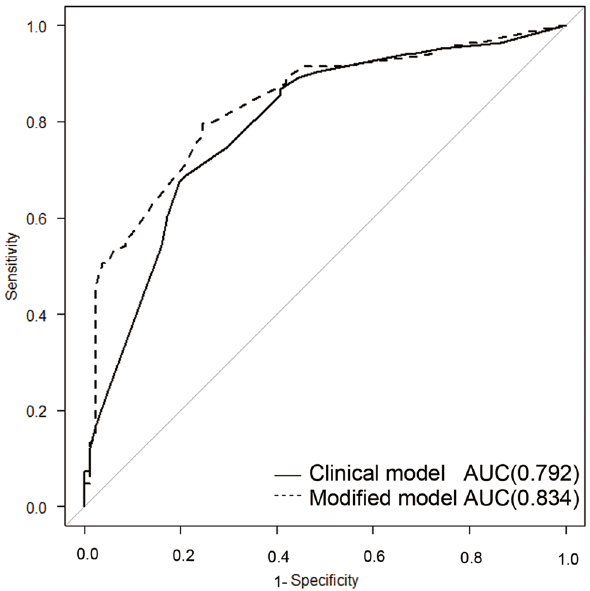
Figure 5. Receiver operating characteristic curves of the clinical model and the modified model. The area under the curve (AUC) of the modified model that included defects in the posteromedial and posterolateral lymphatic groups in addition to clinical risk factors was significantly higher than that of the clinical model that included only dermal back-flow and clinical risk factors.